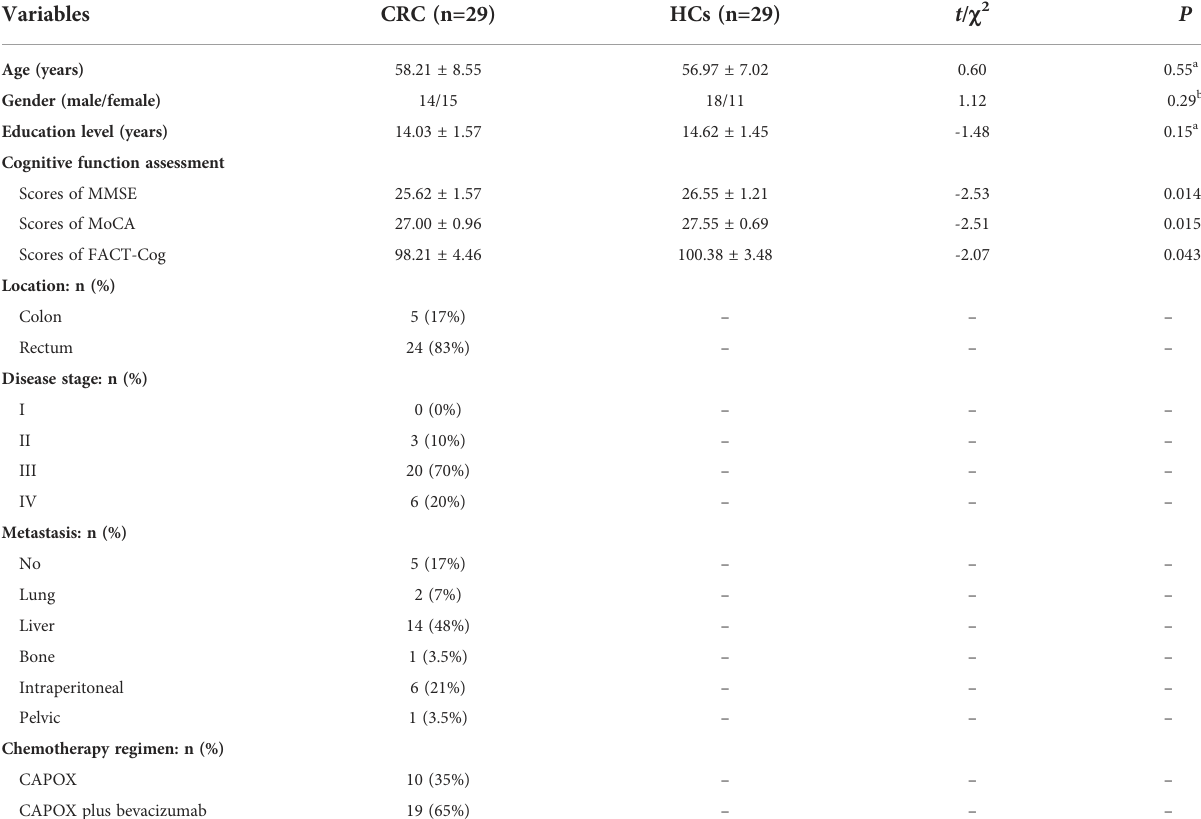
TABLE 1 Demographic and clinical